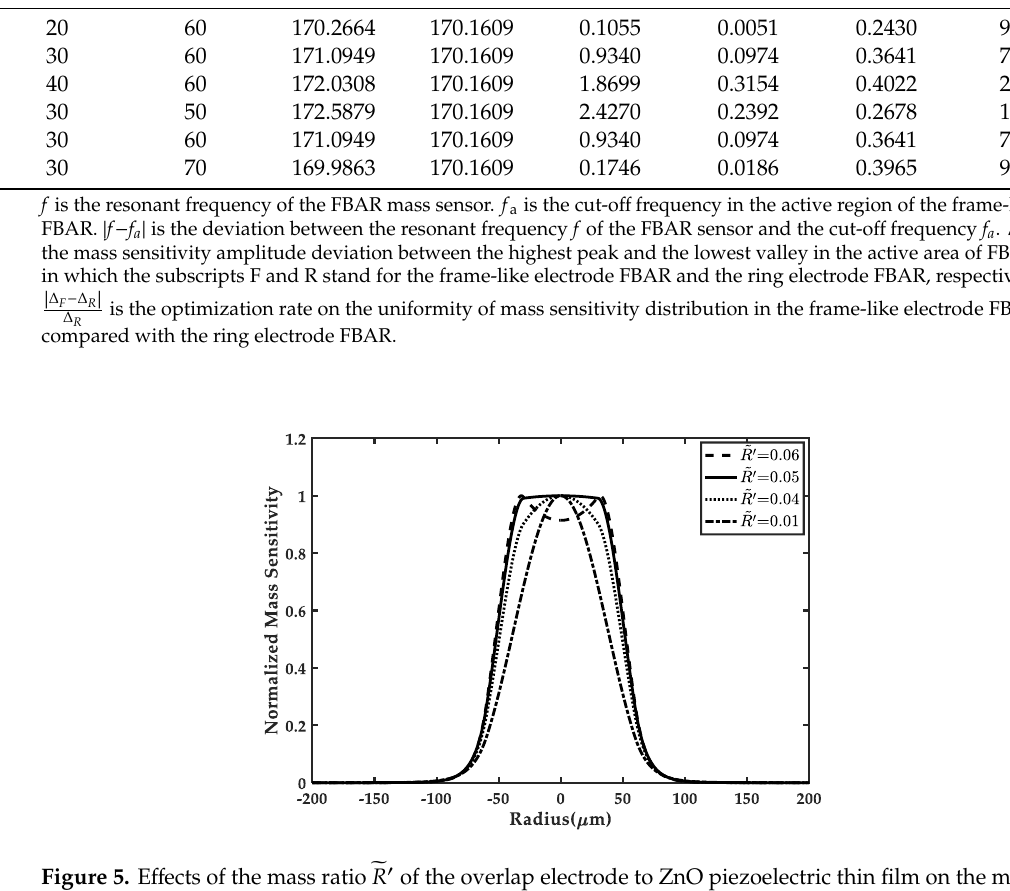
Figure 5. E ff ects of the mass ratio (cid:101) R (cid:48) of the overlap electrode to ZnO piezoelectric thin film on the mass sensitivity distributions in the frame-like electrode FBAR sensor, when r 1 is fixed as 30 µ m and r 2 is fixed as 60 µ m. With the increasing of (cid:101) R (cid:48) , the shape of the distributions change to the concave from convex. The uniform distributions in the active region are obtained for (cid:101) R (cid:48) = 0.05, indicating that the uniform mass sensitivity distributions can be successfully achieved by selecting proper mass ratio through the novel frame-like electrode design. Table 2. The comparison on the uniformity of mass sensitivity of the frame-like electrode FBAR sensor for di ff erent mass ratios (cid:101) R (cid:48) , with r 1 = 30 µ m and r 2 = 60 µ